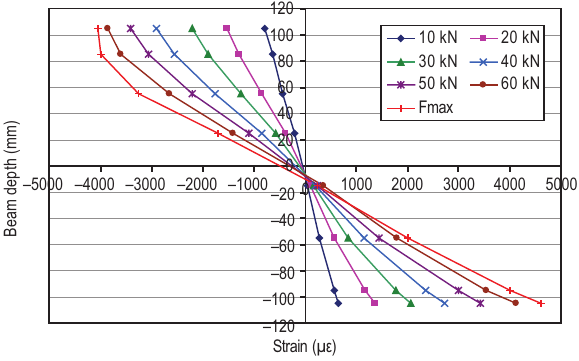
Fig. 9. Strain profile at different load levels for beams reinforced with one CFRP plate (Beam B1)